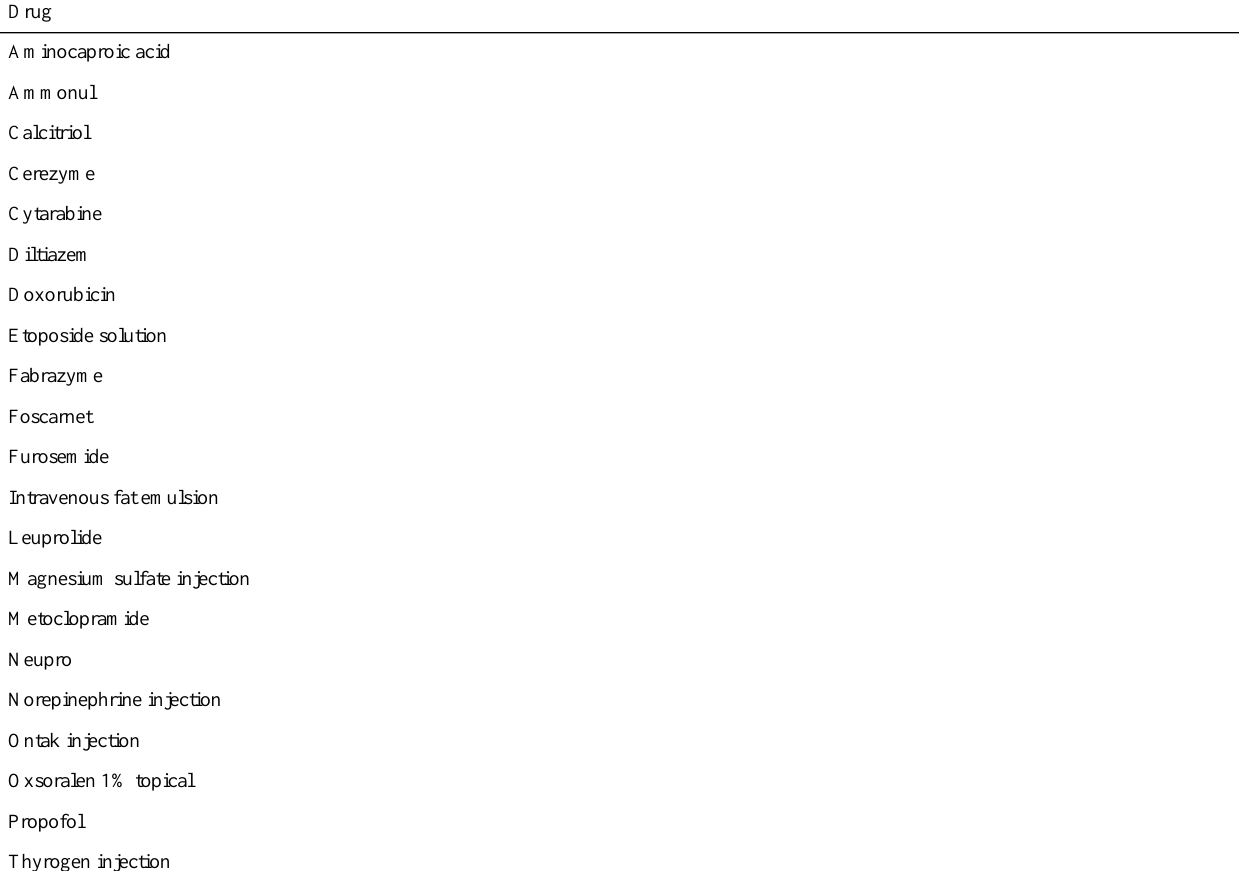
Table 3. US Food and Drug Administration Current Drug Shortage list drugs found only on National Association of Boards of Pharmacy’s